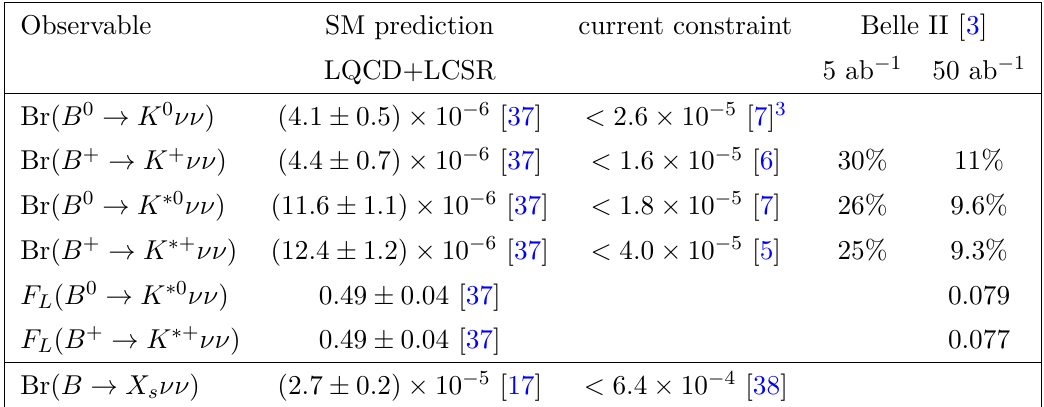
Table 1 . Observables for b → sνν . The SM predictions for the exclusive decays and their un- certainties are based on light-cone sum rules (LCSR) and lattice QCD and are taken from [35] for B → Kνν and from [36] for B → K ∗ νν including a 10% increase of the B → K ∗ form factors due to finite-width effects [39]. The last two columns list the Belle-II sensitivities to exclusive B -meson decays to a K ( ∗ ) meson and active neutrinos [3] if the respective SM predictions are assumed.